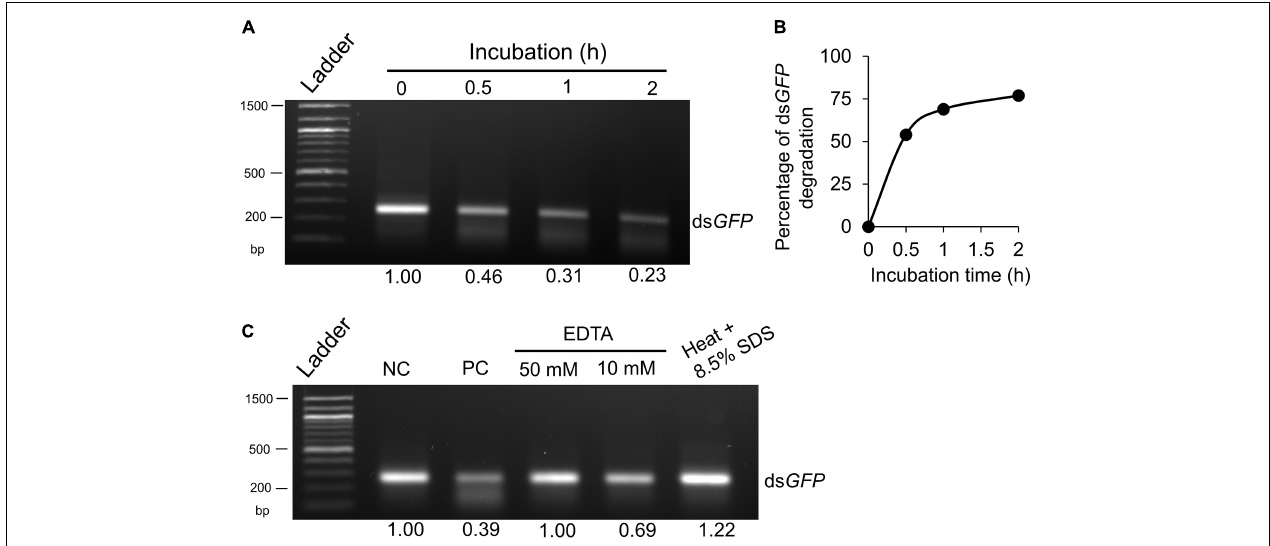
FIGURE 1 | Degradation of double-stranded RNA (dsRNA) ex vivo by midgut fluids of worker ants. (A) ds GFP (200 ng) was incubated with 2 µ g of midgut fluid proteins at 27 ◦ C for 0, 0.5, 1 and 2 h, respectively. (B) The percentage of ds GFP degradation in midgut fluids was calculated based on band intensity in panel (A) . (C) dsRNA degradation in midgut fluids was inhibited by EDTA or heat + SDS treatment. ds GFP (200 ng) was incubated for 0 (negative control, NC) or 2 h (positive control, PC) at 27 ◦ C with midgut fluids as above. ds GFP and midgut fluids were also incubated in the presence of EDTA (50 and 10 mM), or heated at 95 ◦ C for 30 min in 8.5% SDS. After incubation, samples were subjected to RNA extraction by Ribozol, separated on 1.5% agarose gel and visualized by EtBr staining under UV light. Band intensity was quantified by Photoshop and expressed as a ratio relative to the “0” or “negative control,” which was arbitrarily set at 1. Each experiment was repeated at least twice and a representative gel picture was